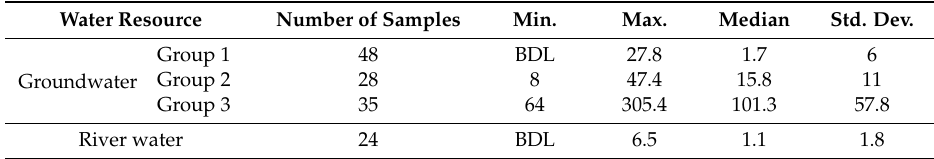
Table 4. Distribution of NO 3 concentrations in various water resources in UB (unit: